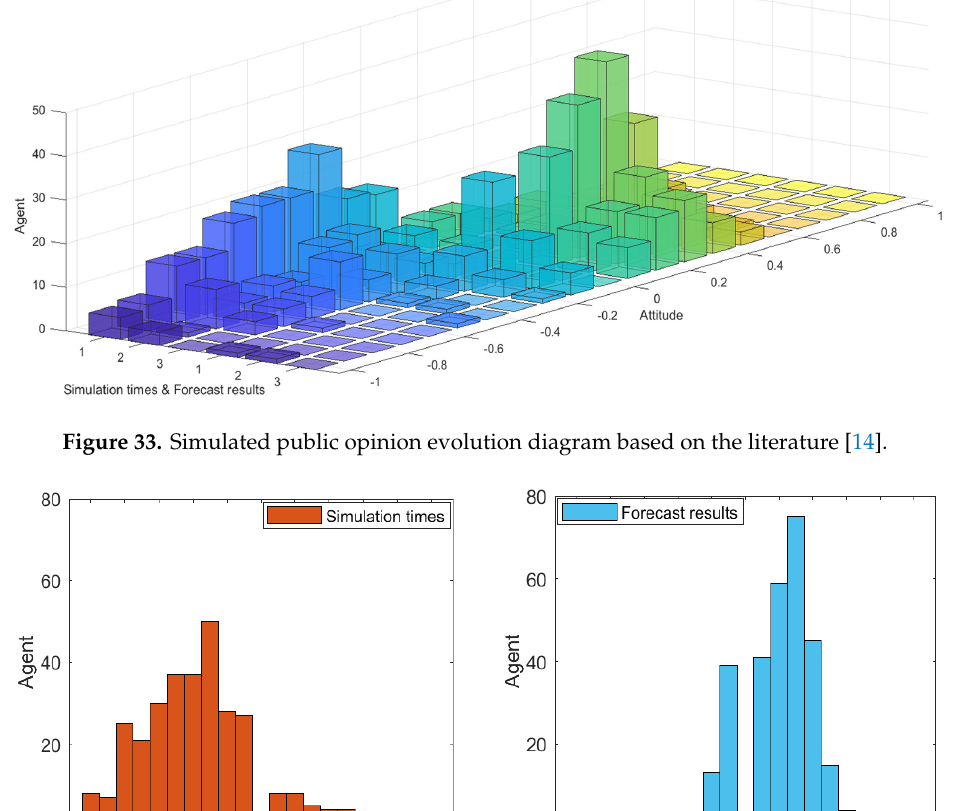
30 of 33 Figure 31. Simulated public opinion evolution diagram. ( a ) 9/3~9/5 simulation results ( b ) 12/22~12/24 simulation results Figure 32. Simulated group attitude distribution histogram. ( a ) 9/3~9/5 simulation results; ( b ) 12/22~12/24 simulation results. Figures 31 and 32represent the simulated public opinion evolution diagram and group attitude distribution histogram of “Liu Qiangdong sexual assault” by the model proposed in this paper. In order to better simulate the process of public opinion reversal, three simulations were carried out on public opinion evolution during 9/3~9/5, whose results were corresponding to the public opinion evolution during 12/22~12/24 (such as: simulation times 1 corresponds to case 9/3, forecast results 1 corresponds to case 12/22). From Figures 31 and 32, three model simulations presented good state of public opinion evolution in the first stage (9/3~9/5), and the evolution trend of public opinion is consistent with the evolution of the case data on the whole, simulated group distribution state is consistent with case data distribution, the simulated prediction results are basically consistent with the actual evolution results in the second stage (12/22~12/24). This shows that the model proposed in this paper can well simulate the evolution of real public opinions and predict the evolution results of